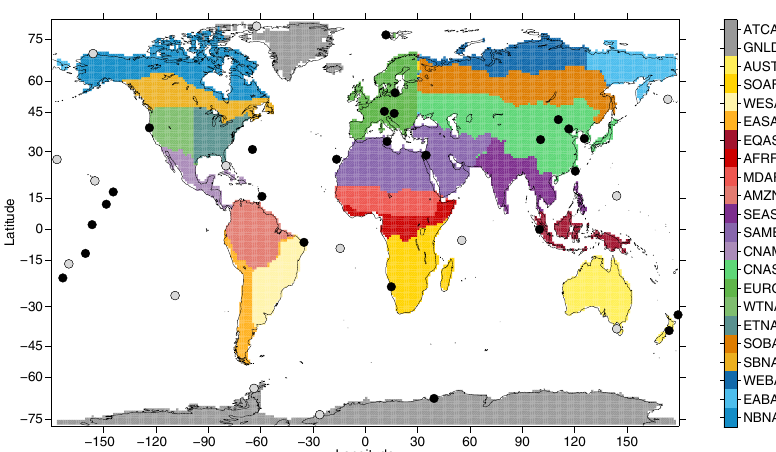
Figure 1. Map of stations where CO 2 from the pulse-response code is computed. Table 1 lists the station identifiers and locations. The GEOS-Chem regions defined in the pulse-response code (see Table 2) are shaded and grouped according the Arctic (blue shades), boreal (orange shades), NH temperate (green shades), NH subtropical (purple shades), tropical (red shades), and SH land (yellow shades) ecoclimate regions. Greenland and Antarctica (gray shades) were excluded from the analysis. Gray circles indicate a subset of stations from which the atmospheric annual CO 2 amplitudes were computed from 1985 to 2013 monthly mean observations (bold stations in Table 1).